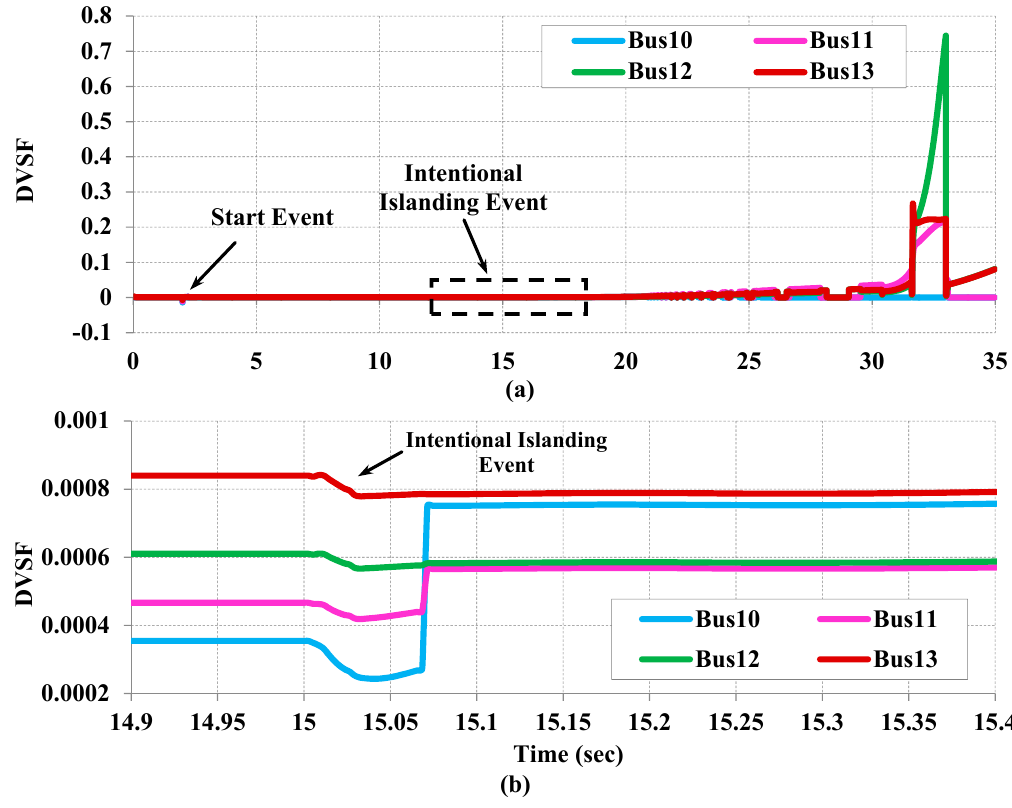
Figure 12. Dynamic Voltage Sensitivity Factor ( a ) full window of DVSF for bus-bars in the island-2 ( b ) expanded window for DVSF during ‘Intentional Islanding Event’.